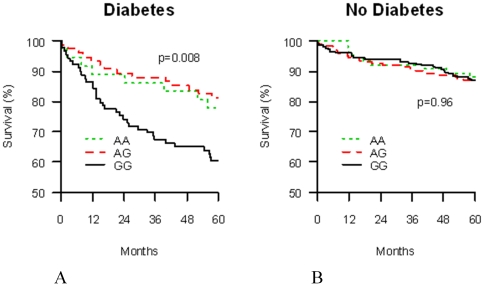
In diabetic patients, PPARA −54,642 A allele carriers have deceased mortality after acute coronary ischemia.Kaplan-Meier estimates of mortality stratified by PPARA −54,642 genotype in patients with (A) and without (B) DM. p-values between genotype groups are shown. (p-value for genotype by diabetes interaction = 0.008).